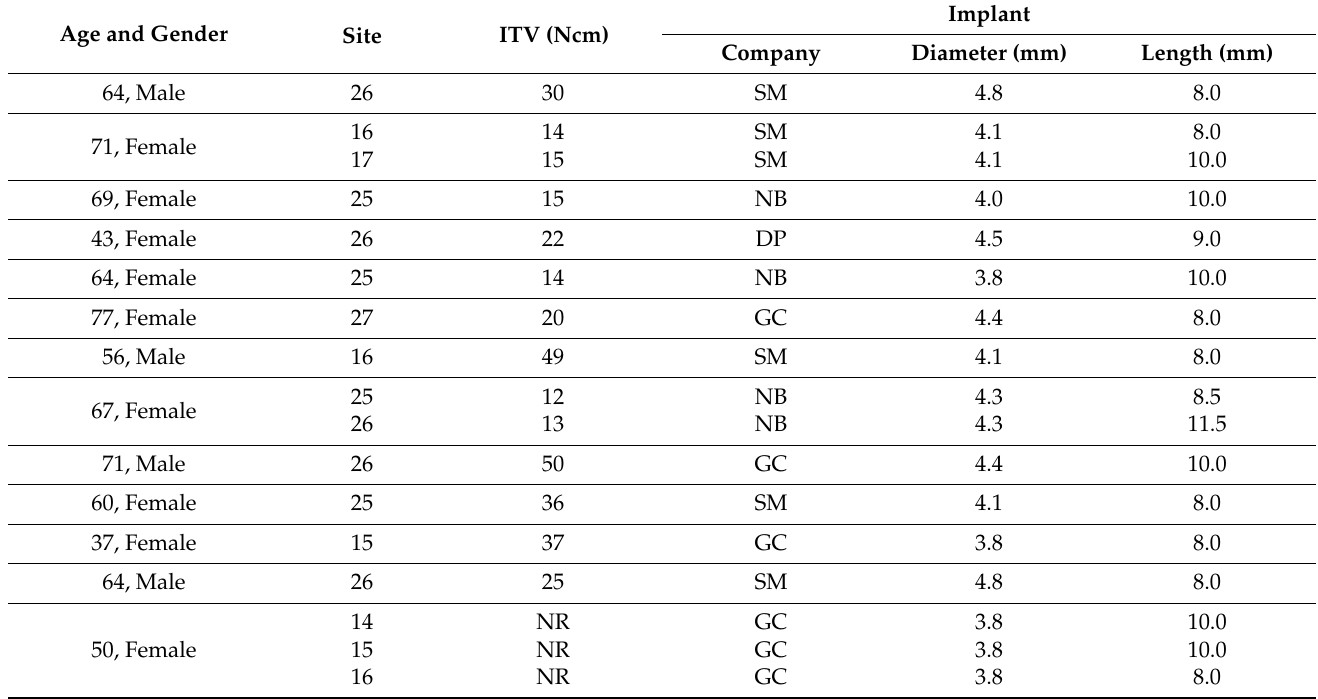
Table 3. Data on implant placement.